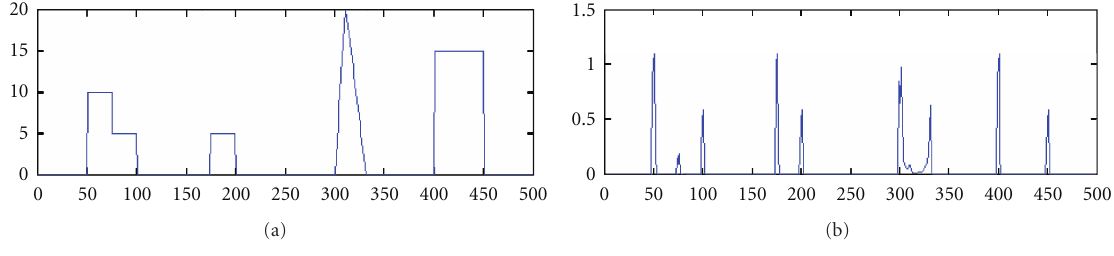
Figure 2: (a) A 1D signal and (b) local frequency map.